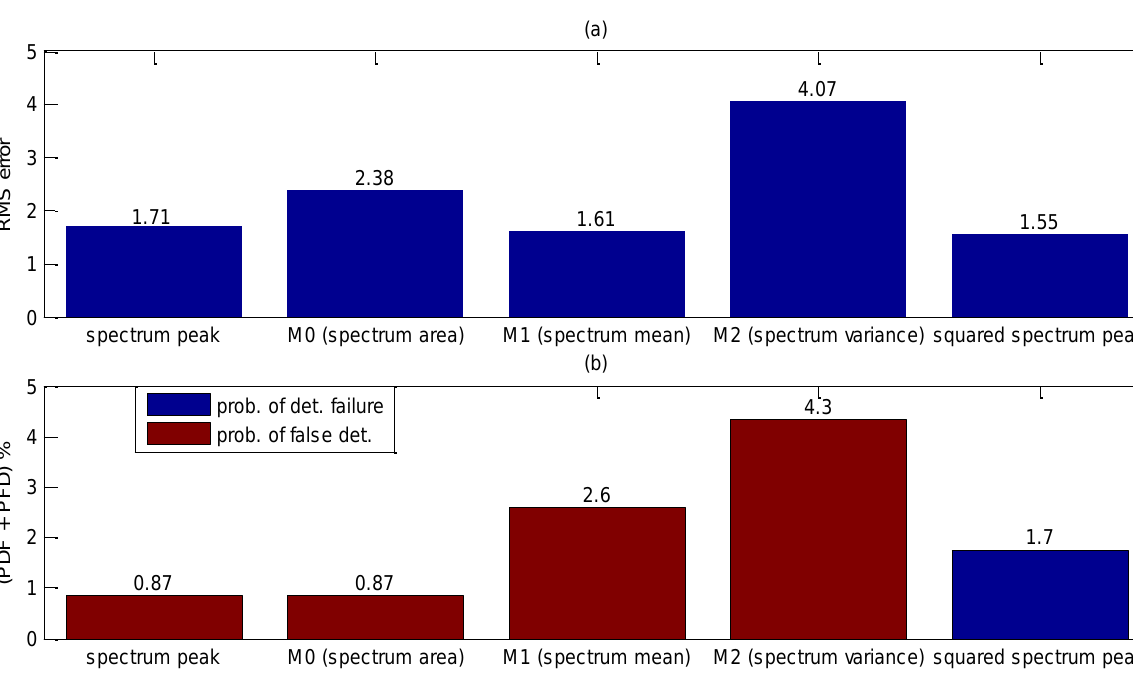
Figure 11. Accuracy results of detection liquid-gas interface without using tracing powder. ( a ) RMS error. ( b ) Probability of false detection and detection failure results.